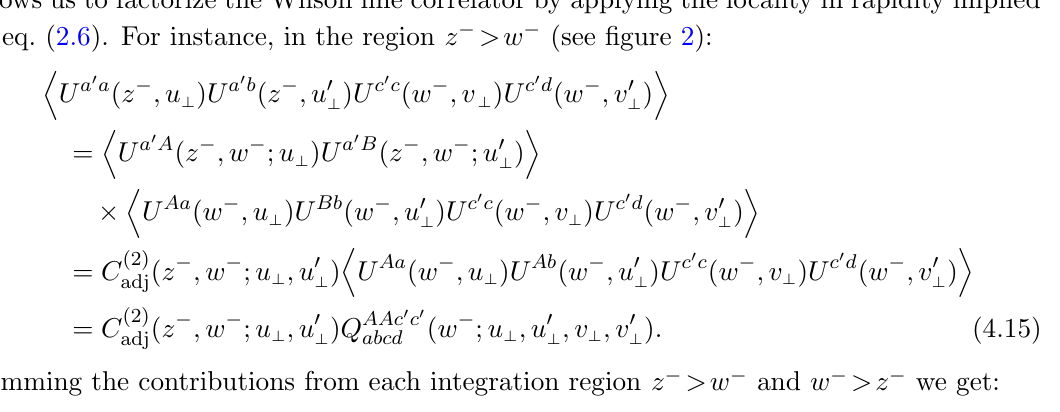
Figure 2 . Schematic representation of the correlator factorization performed in eq. (4.15). allows us to factorize the Wilson line correlator by applying the locality in rapidity